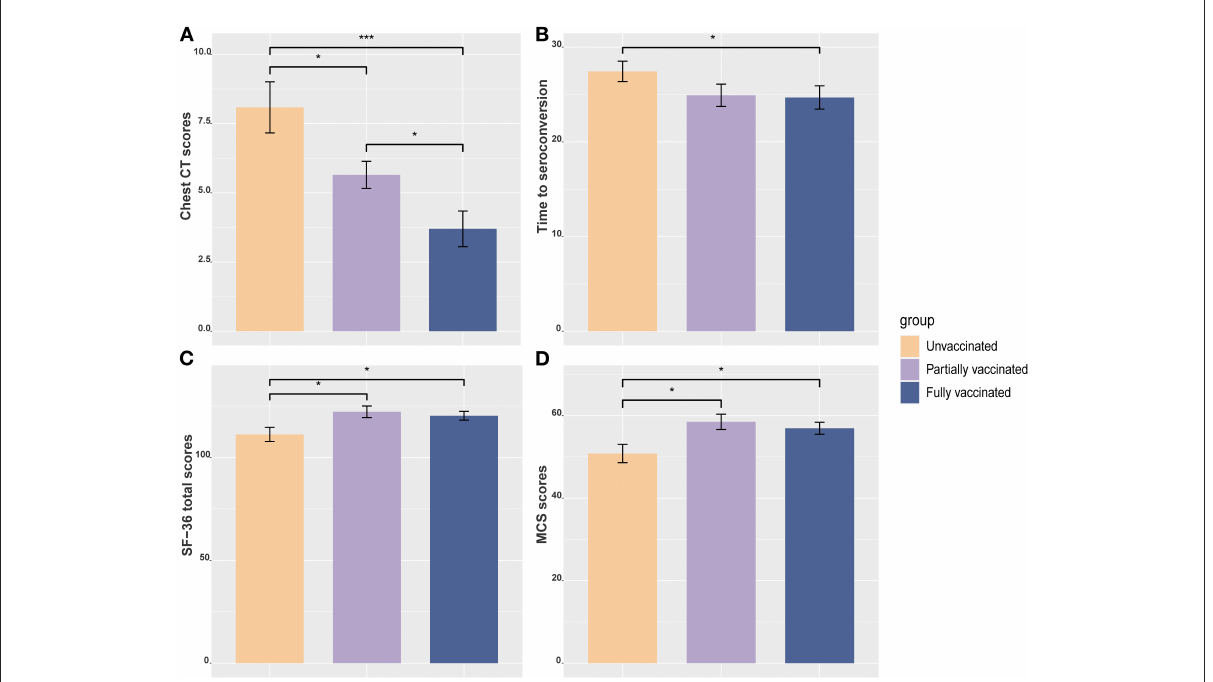
FIGURE1 Bar plots among different vaccination status groups with the mean and standard error of the mean are shown. (A) Between-group differences in chest CT scores. (B) Between-group differences in time to seroconversion. (C) Between-group differences in SF-36 total score. (D) Between-group differences in MCS score. * P < 0.05; *** P < 0.001. MCS, mental component